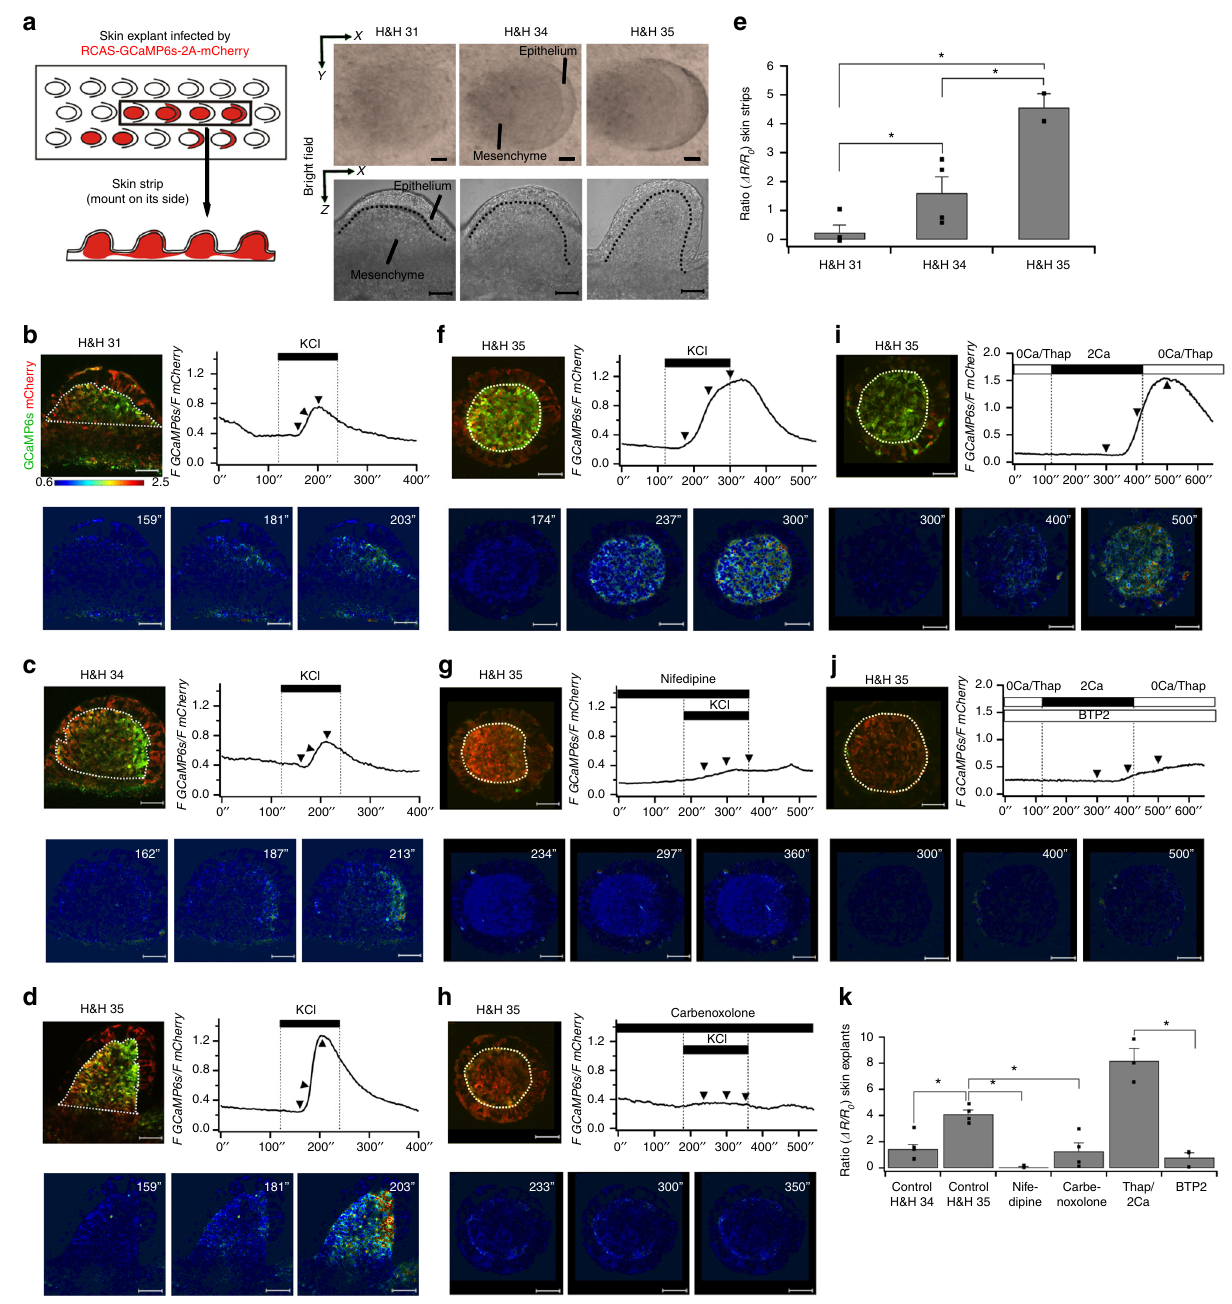
Fig. 2 Functional VGCCs, gap junctions and CRAC channels in elongating feathers. a Schematic drawing exhibiting the skin explant and strip con fi guration used for time-lapse Ca 2 + imaging. Bright fi eld images of feather buds at different developmental stages in skin explants and strips are shown. Dotted lines highlight epithelial-mesenchymal boundaries. Scale bars, 50 μ m. b – d Time-lapse Ca 2 + imaging of feathers from skin strips at different stages ( n = 3 for each stage). Dotted lines indicate regions of interest (ROI) for quanti fi cation ( ′′ denotes seconds). Pseudocolor images of the ratios are presented at selected time points (arrowheads). Scale bar, 50 μ m. e Quantifying change of mesenchymal Ca 2 + increases in feathers from skin strips. R o : baseline F GCaMP6s/F mCherry ratio before KCl application. Δ R : the peak ratio subtracts R P < 0.05 (Wilcoxon rank test). Dots represent individual o . Mean ± s.e.m. * data points. f Time-lapse Ca 2 + imaging of feathers in skin explants at H&H 35 ( n = 16/16). g Pretreatment with 50 μ M Nifedipine for 3 min greatly dampened the KCl-induced Ca 2 + elevation ( n = 4/4). h Pretreatment with 150 µ M Carbenoxolone for 30 min signi fi cantly reduced the KCl response ( n = 4/4). i Feather buds pretreated for 30 min with 0 mM Ca 2 + solution including 10 µ M Thapsigargin exhibited notable Ca 2 + in fl ux after perfusion of 2 mM Ca 2 + solution ( n = 3/3). j 5 µ M BTP2 signi fi cantly reduced the Ca 2 + in fl ux ( n = 3/3). k Quanti fi cation of Ca 2 + response in feathers from skin explants under different treatments. Mean ± s.e.m. * P < 0.05 (Wilcoxon rank